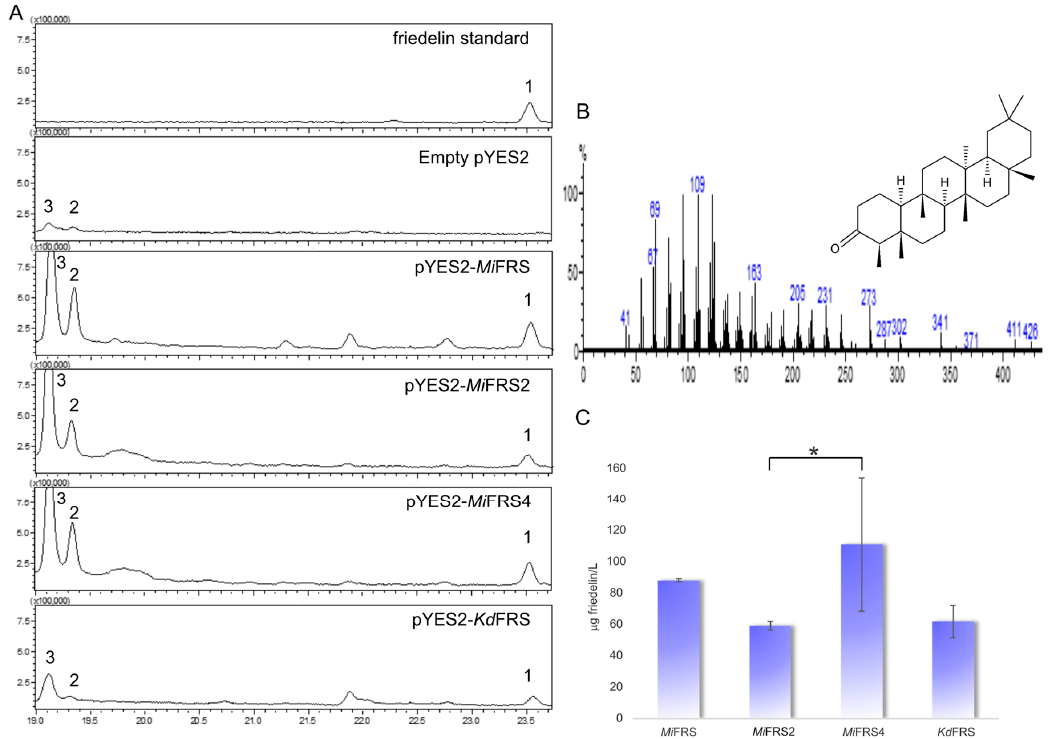
Figure 5. Friedelin production by the Mi FRS sequences and Kd FRS. ( A ) Total ion chromatograms (TIC) for friedelin (1) standard and in the different samples from yeast extract, except in the yeast extract from empty vector sample. Peaks 2 and 3 correspond to the accumulation of compounds from the ergosterol pathway, namely 4,4-dimethylzymosterol and lanosterol (mass spectra in Figure S4); ( B ) One of the mass spectra with the fragmentation patterns for friedelin, used to confirm its production in the yeast extracts. ( C ) Quantified production of friedelin in the different samples. Values are denoted in µg of friedelin by liter of cultivated inocula of strain VZL1303, as the average of three different extracts with standard deviation bars. Asterisk (*) represent significative statistical difference only between Mi FRS2 and Mi FRS4 the samples according to Tukey’s analysis ( p ≤ 0.05). However, production of friedelin by Mi FRS and Kd FRS are not significantly different between each one or compared to Mi FRS2 and Mi FRS4.